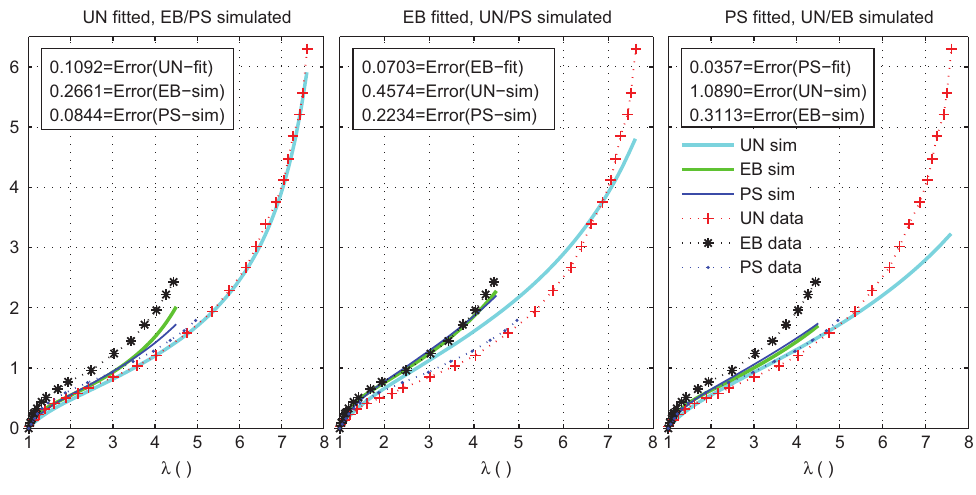
Figure 11 Performance of the 8-chain model on the Treloar data. The fitting quality in UN is excellent (left), but overestimation and underestimation occur in UN simulations by the EB- and PS-fitted para- meters,